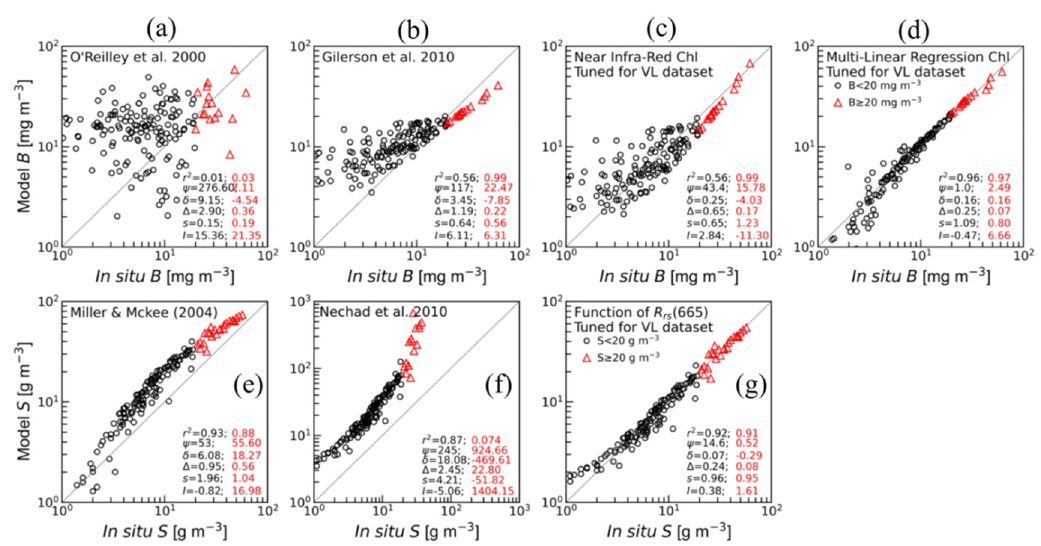
Figure 7. Comparison between the in situ and modelled 𝐵 ( a – d ) and 𝑆 ( e – g ) from various algo- rithms using the VL dataset ( 𝑁 = 162 ): O’Reilly et al. [33] ( a ), Gilerson et al. [36] ( b ), Gilerson et al. [36] ( c ) with tuned coefficients for VL, the algorithm using blue, green, and red reflectance based on multi-linear regression ( d ), Miller and McKee [38] ( e ), Nechad et al. [39] ( f ), and the algorithm using R rs ( 665 ) equipped with exponential function ( g ). Note that algorithm results from c, d, and g were tuned for VL waters. Equations of all algorithms are provided in Table 2. The statistical values in black colour (black circles) are for B < 20 mg m − 3 and S < 20 g m − 3 and the ones in red colour (red triangles) are for B ≥ 20 mg m − 3 and S ≥ 20 g m − 3